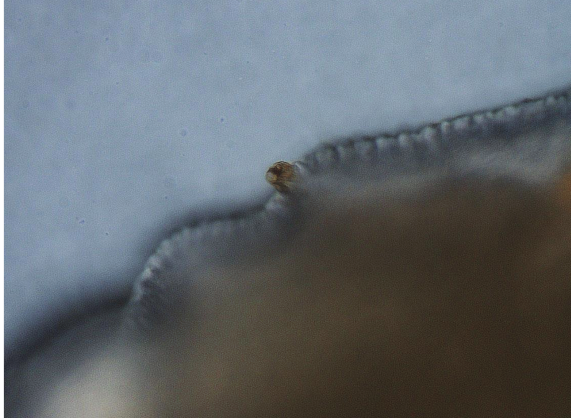
Figure 11: A turreted spiracle on the penultimate abdominal segment.